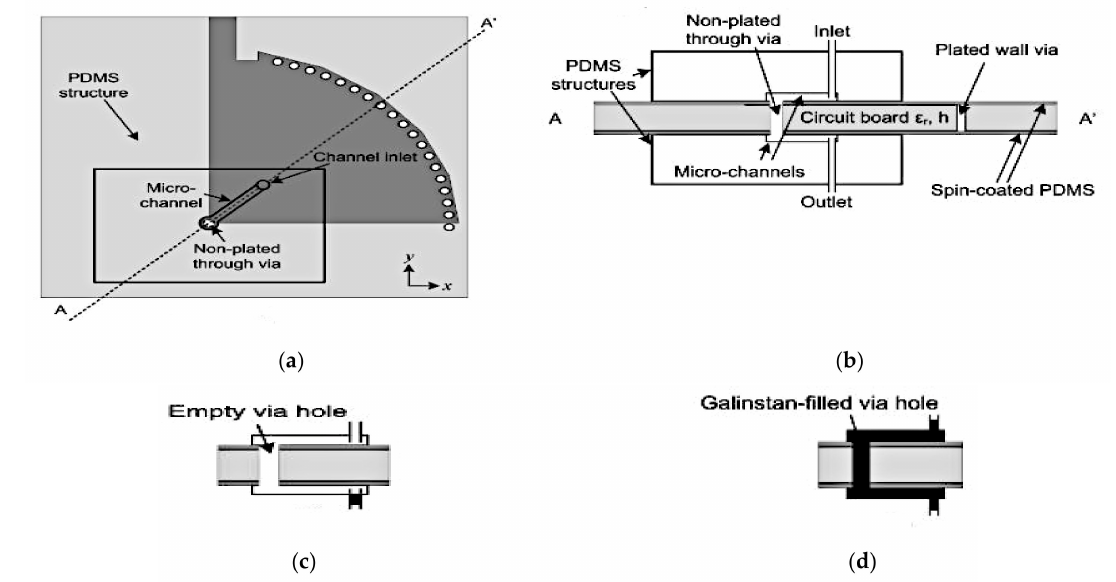
Figure 15. The proposed reconfigurable quarter-mode substrate integrated waveguide (QMSIW) antenna. ( a ) Top view. ( b ) A-A’ cross section view. ( c , d ) ON and OFF states of via [49].